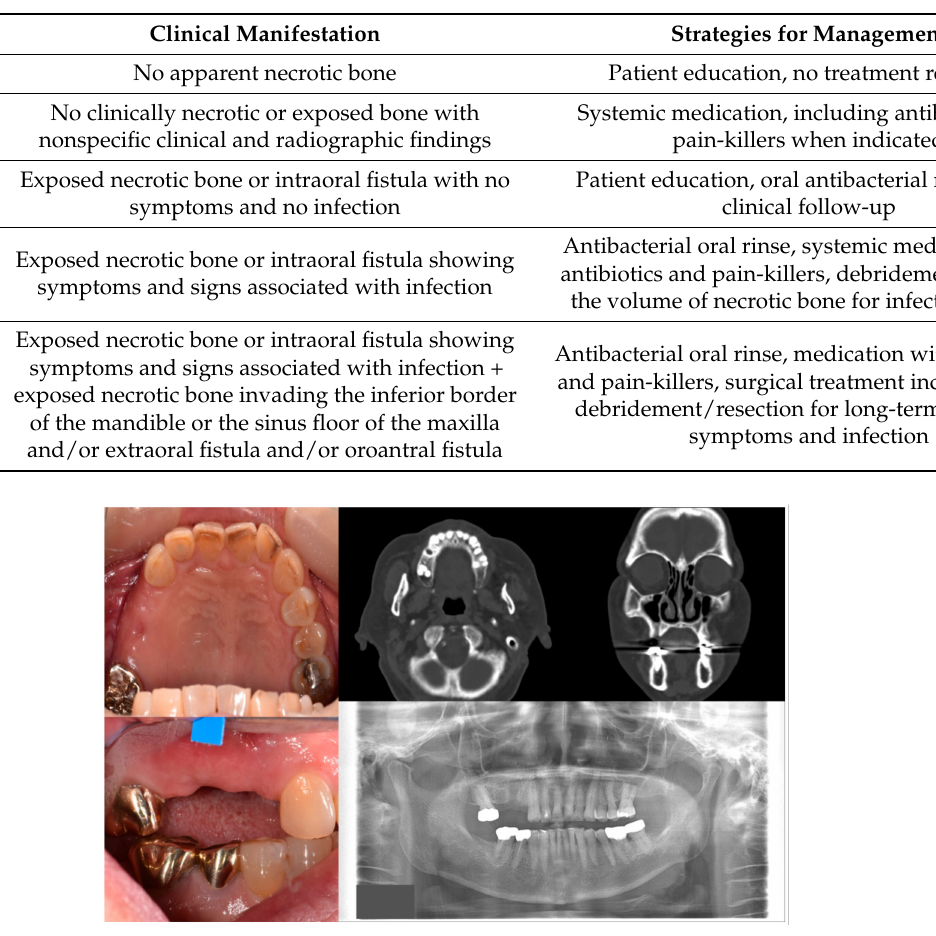
Figure 1. Case 1 with MRONJ Stage 0: Clinical photos, panoramic view, and computed tomography imaging showing non-significant findings on the maxillary right posterior area. An 81-year-old female patient with a history of taking oral alendronate for five years complained of pain after removing the right upper second premolar five months before. There were no specific findings other than slight soft tissue depression in the area and hard tissue defect presumed to be an extraction